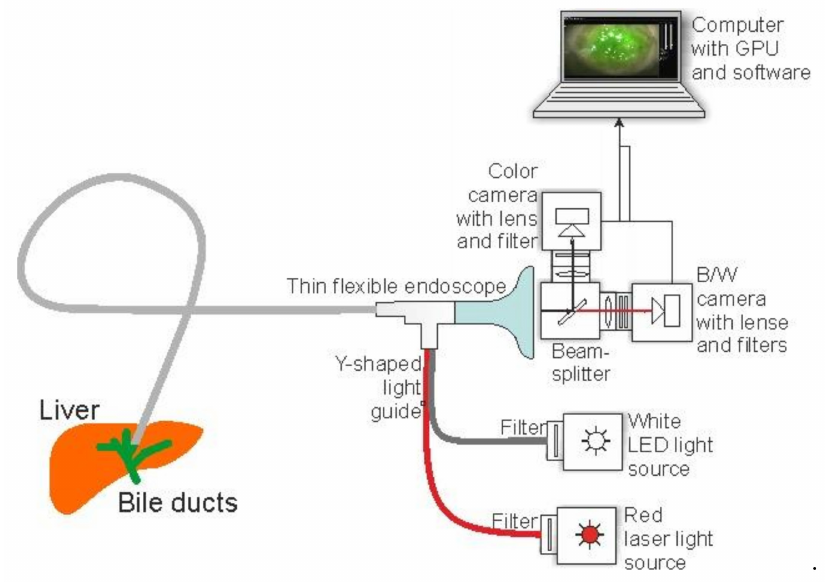
Figure 1. Schematic description of fluorescent video